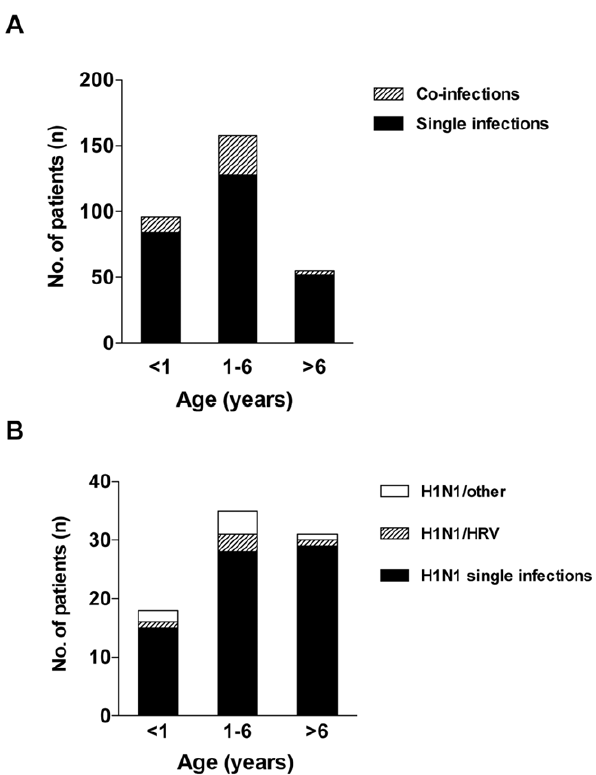
Figure 3. Co-infections and age. Comparison of number of co- infections according to age between children under 1 year ( , 1), children 1–6 years (1–6) and children over six years ( . 6) in (a) all children and (b) H1N1-positive children. H1N1-positive co-infected children divided into co-infection with HRV (H1N1/HRV) and co- infection with other viruses (H1N1/other).